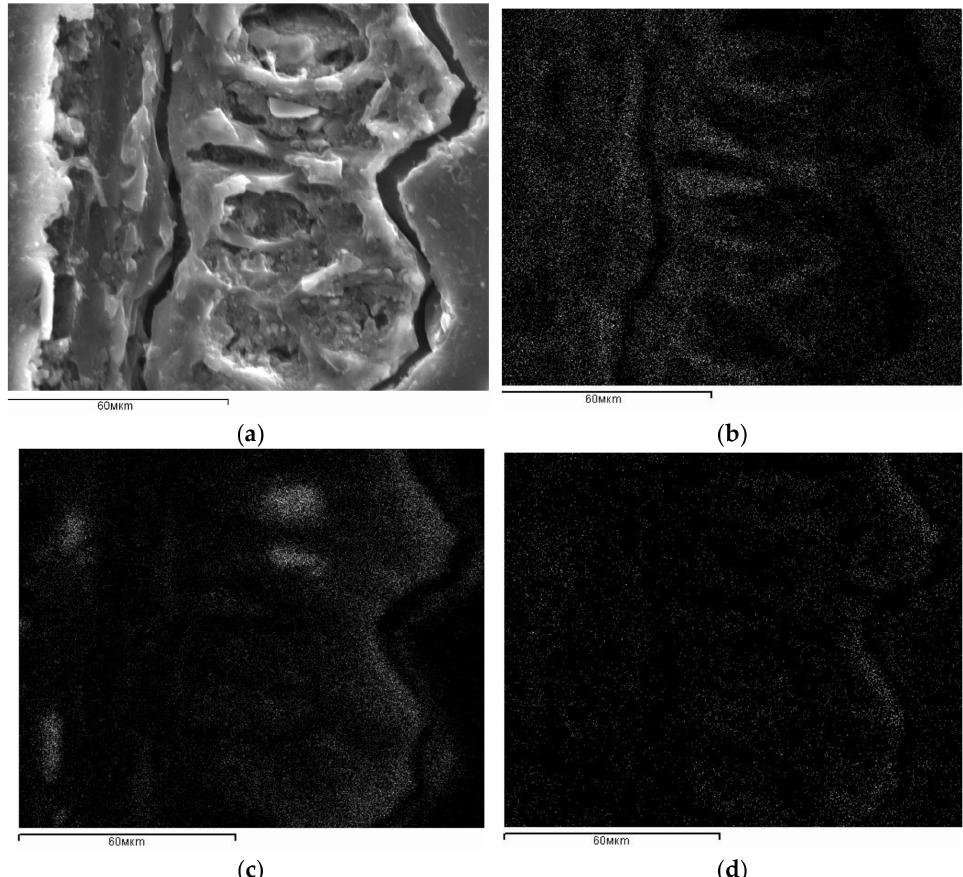
Figure 3. SEM micrographs of the rice husk carbonized at 650 ◦ C sample: ( a ) longitudinal section of rice husk carbonized at 650 ◦ C; ( b ) distribution of carbon; ( c ) distribution of silicon; ( d ) distribution of